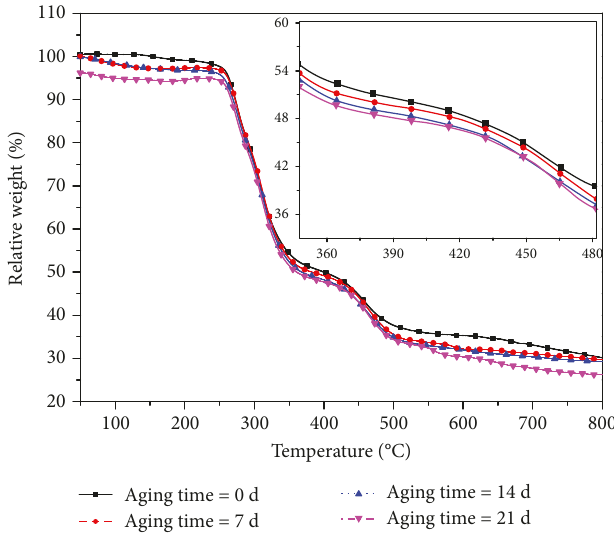
Figure 5: Thermogravimetric curves of the